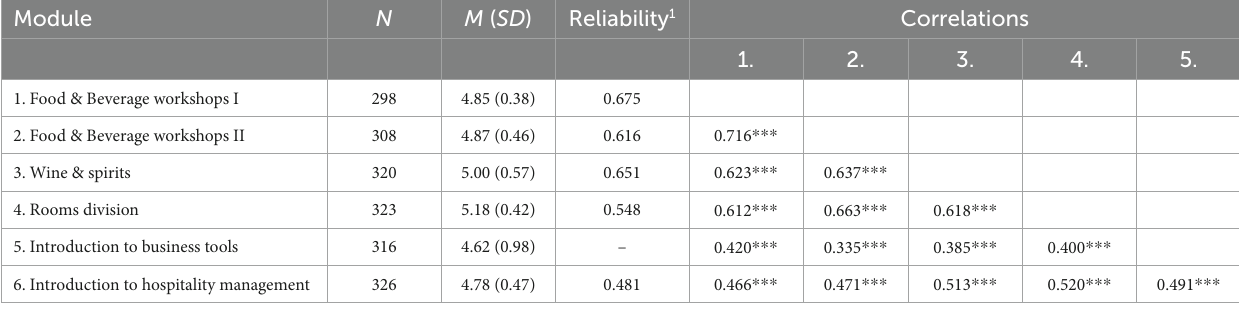
TABLE 2 Module grades: descriptive statistics, internal consistencies, and correlations. Module